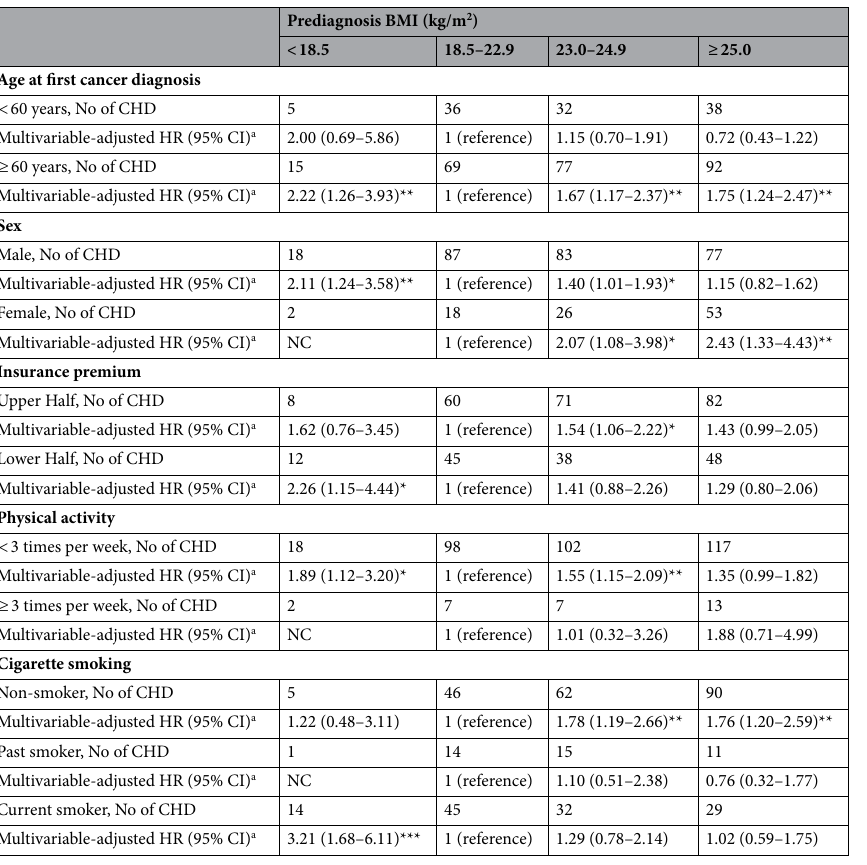
Table 4. Subgroup analysis of coronary heart disease (CHD) risk among cancer survivors by prediagnosis body mass index (BMI). Data above are presented in numbers, HR, and HR (95% CI). HR hazard ratio, CI confidence interval, NSAIDs non-steroidal anti-inflammatory-drugs, NC not calculable. a Adjusted for socioeconomic factors (age, sex, residential area, insurance premium), lifestyle (smoking status, alcohol consumption, and physical activity), medical characteristics (fasting serum glucose, total cholesterol, blood pressure, and Charlson comorbidity index), family history (cardiovascular disease), depression, and medication use (aspirin, statin, anti-hypertensive drugs, anti-diabetic drugs, and NSAIDs) except for the variable used for each stratified analysis. * p < 0.05, ** p < 0.01, *** p <